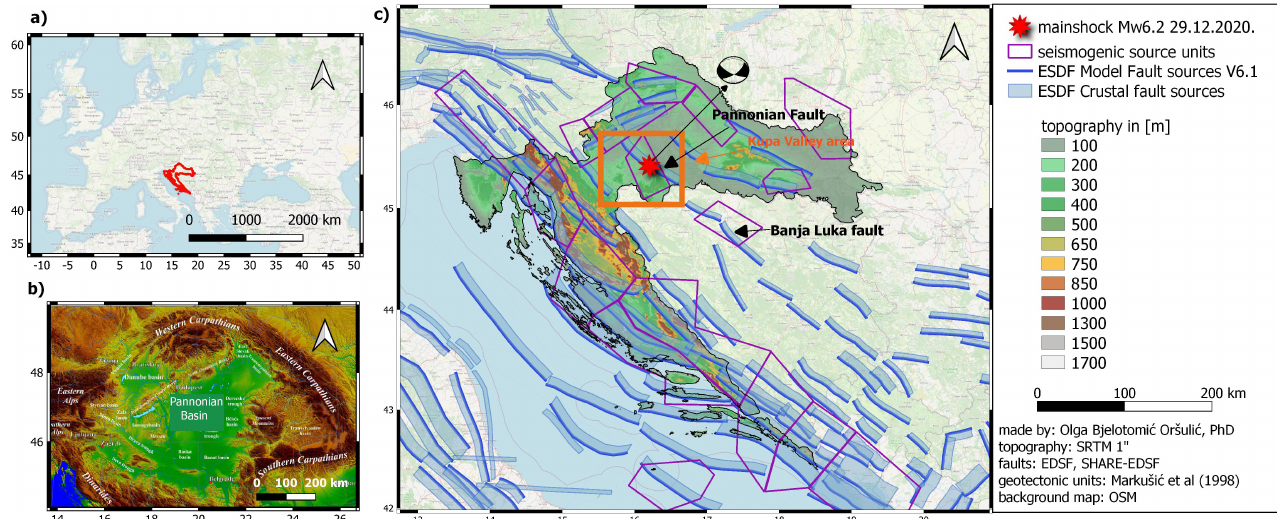
Figure 1. Figure shows the location of the Republic of Croatia ( a ), Pannonian Basin structure ( b ), and geotectonic units and seismic faults and zones over Croatia ( c ). Pannonian Basin in ( b ), is derived from [36], while the faults are derived from EDSF project, model V6.1 [32], and seismic zones from [31]. Topography is generated from the 1 arc second SRTM [37], with Open Street Maps in the